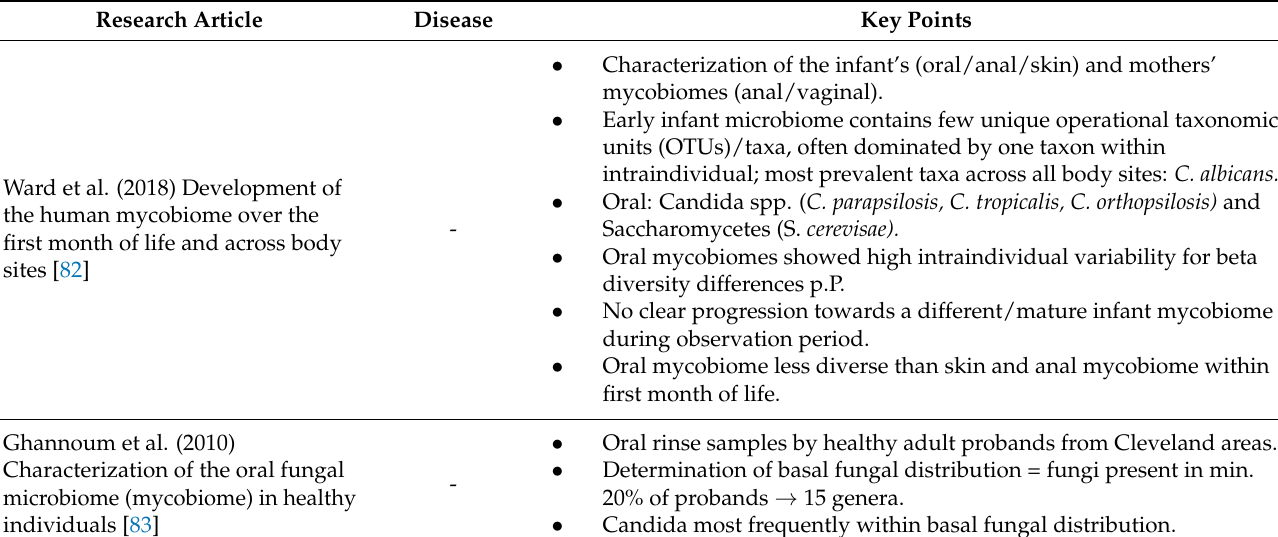
Table 3. Overview of published research articles of the naso-/oropharyngeal mycobiome of the human upper respiratory